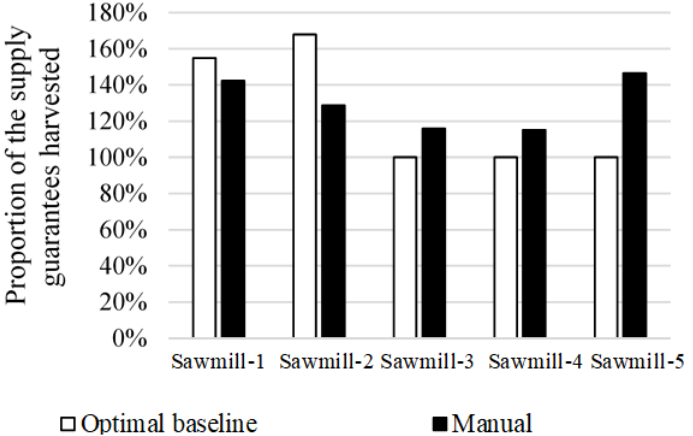
Figure 5. Proportion of volumes allocated to factories in the optimal scenario of reference in compari- son to the manual scenario.